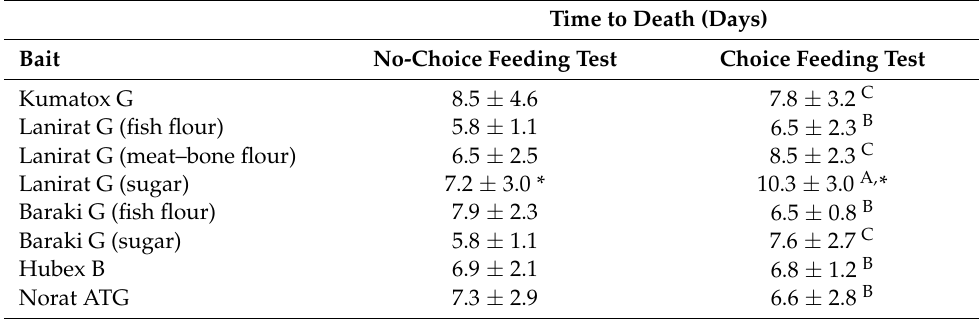
Table 2. Times to death achieved in no-choice and choice laboratory feeding tests with house mice. Data are presented as means ± SD; significance at the level p <